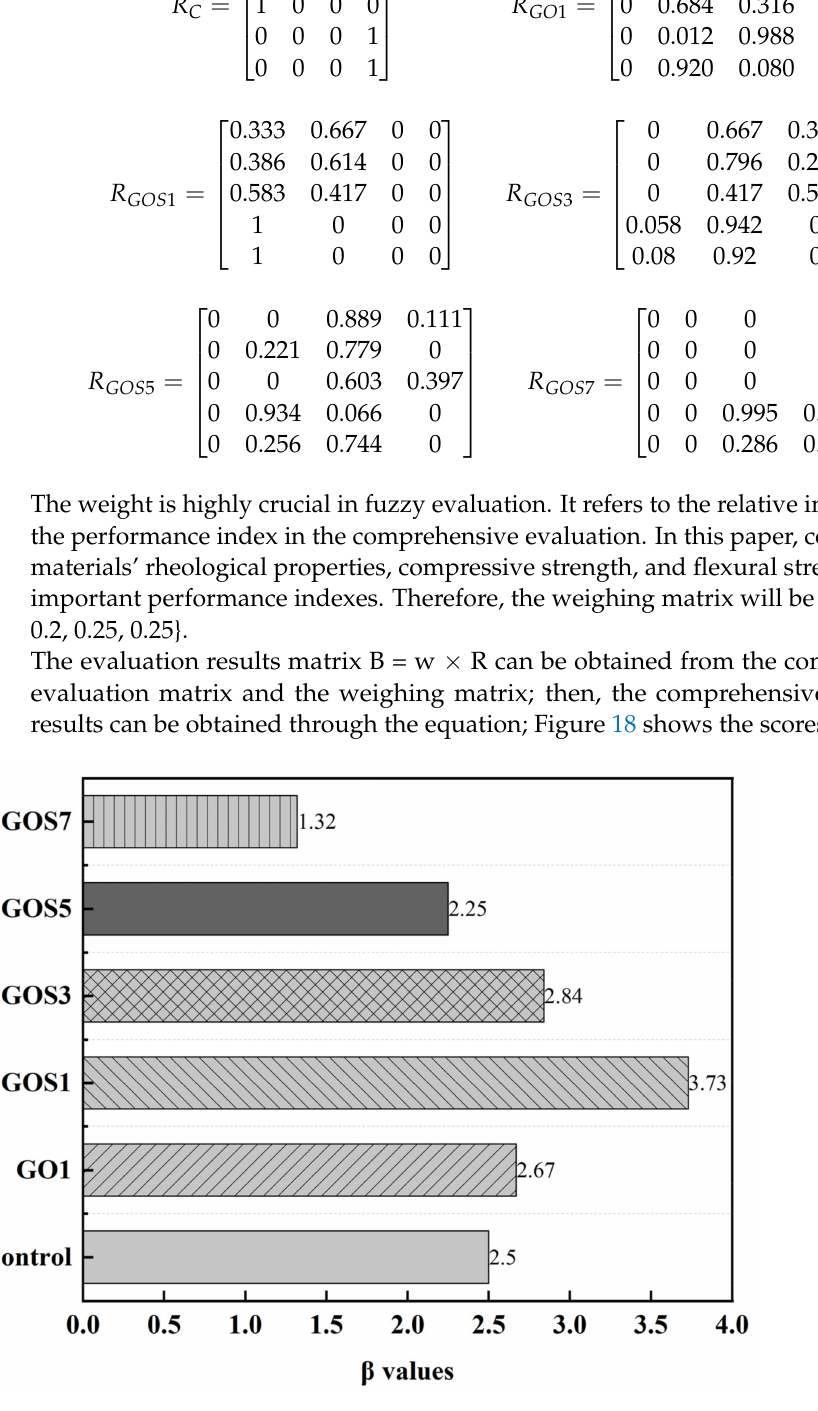
Figure 18. Bar chart of the comprehensive evaluation scores of the fuzzy